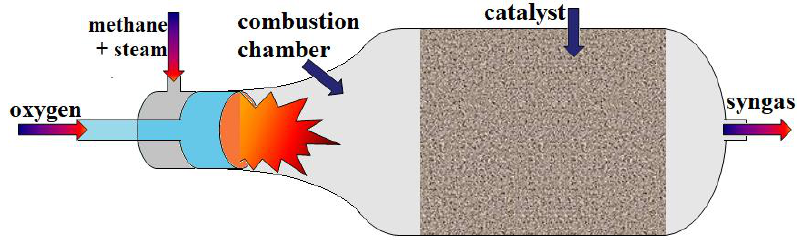
Figure 4. Scheme of the reactor for autothermal reforming.